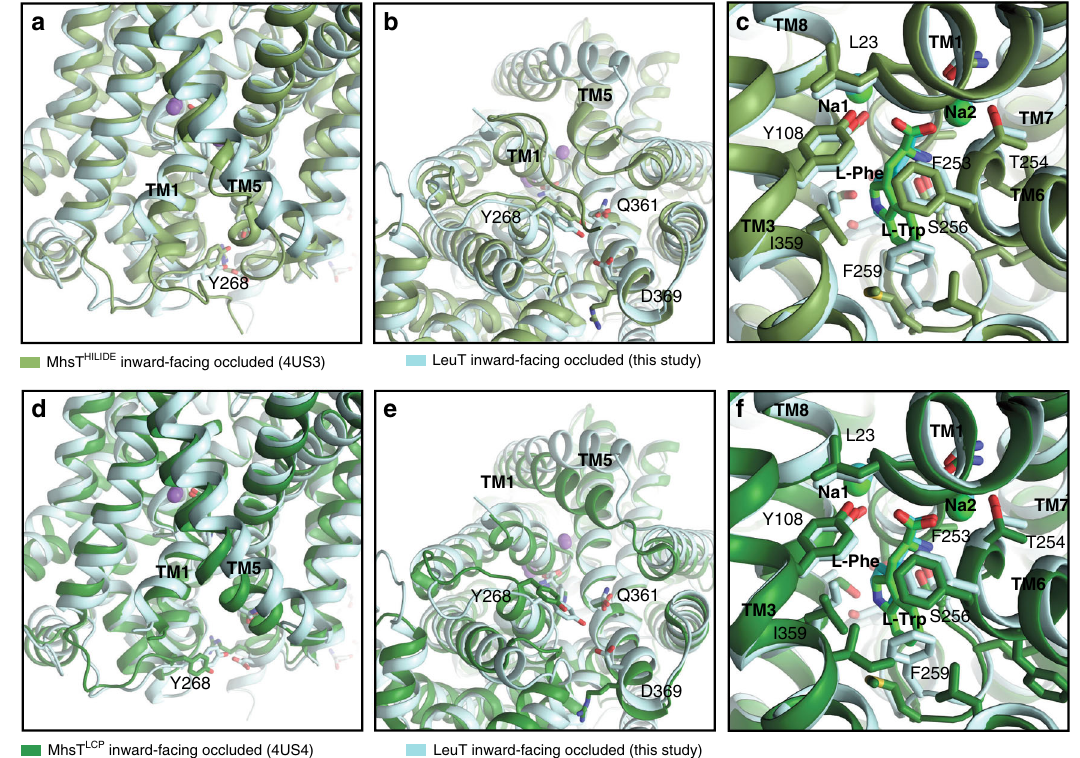
Fig. 6 Comparison of the LeuT W8A structure with the structures of MhsT. a – c Overlay of the LeuT W8A structure in inward-facing occluded conformation (this study; light blue) with the MhsT HILIDE structure in inward-facing occluded state (PDB-ID: 4US3 13 ; light green). a Close-up view of the intracellular vestibule region from the membranous side with transmembrane segments (TMs) 1, 5, and Y268 residue labelled. b Close-up view of the intracellular vestibule from the cytoplasmic side with TM1, 5 and internal gate residues (Y268, Q361, and D369) labelled and shown as colored sticks. c Close-up view of sodium and substrate binding sites with selected coordinating residues labelled and shown as colored sticks. For each structure, two sodium ions are shown as spheres and substrates as darker sticks in the corresponding colors. Residues are selected within a distance of 4 Å. d – f Overlay of the LeuT W8A structure in inward-facing occluded conformation (this study; light blue) with the MhsT LCP structure in inward-facing occluded state (PDB-ID: 4US4 13 ; dark green). Panel presentation is identical as in a – c